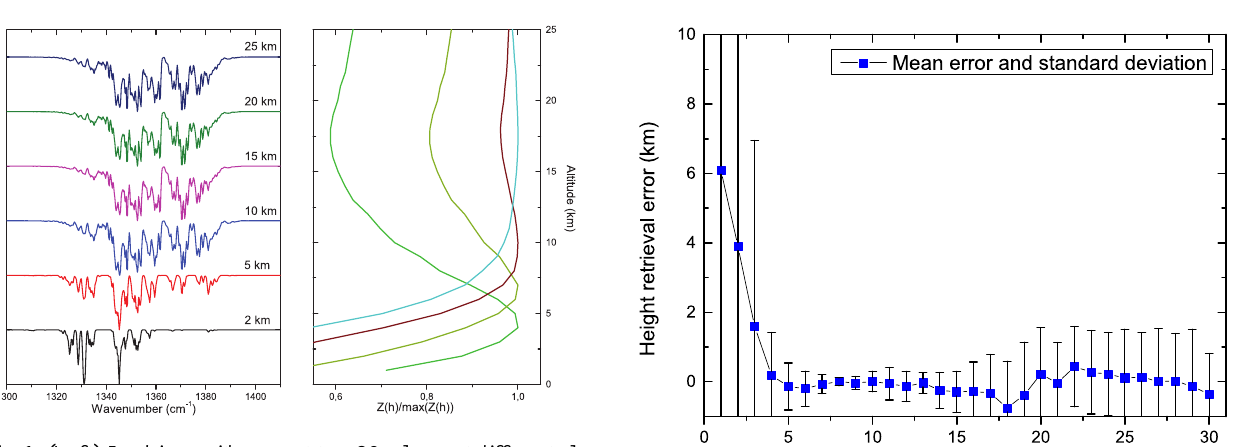
Fig. 1. (Left) Jacobians with respect to a SO 2 layer at different al- titudes. They have been normalised and offset for display purposes. (Right) The Z function acting on different observed IASI spectra of Nabro. The values have been normalised to ease comparison.